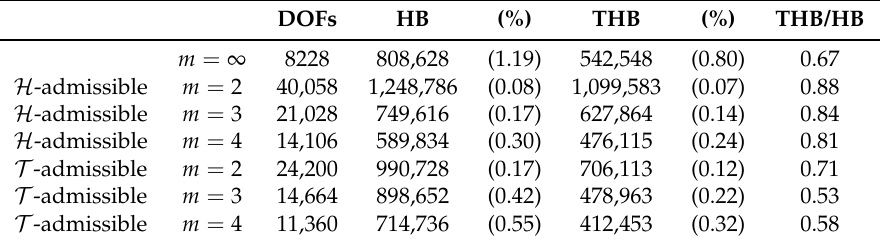
Table 1. Number of nonzeros of the stiffness matrix for p = ( 2,2 ) .